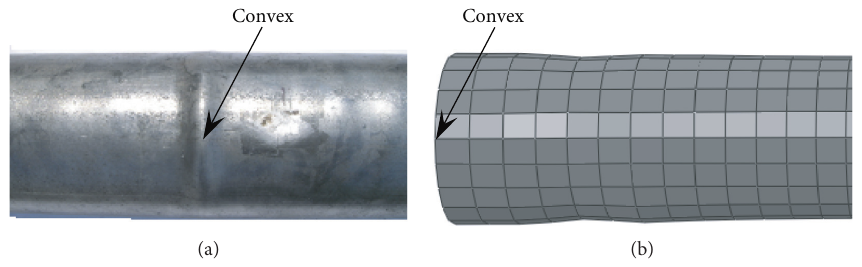
Figure 15: Failure modes of steel tube with middle section. (a) Test result. (b) FE result.